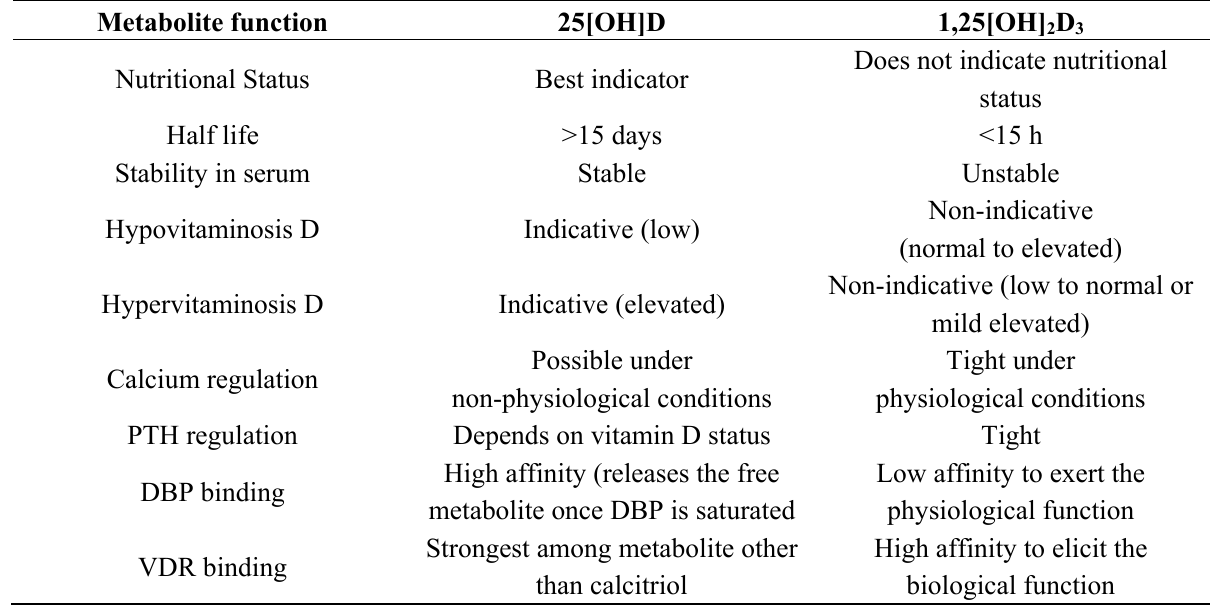
Table 3. Calcidiol versus